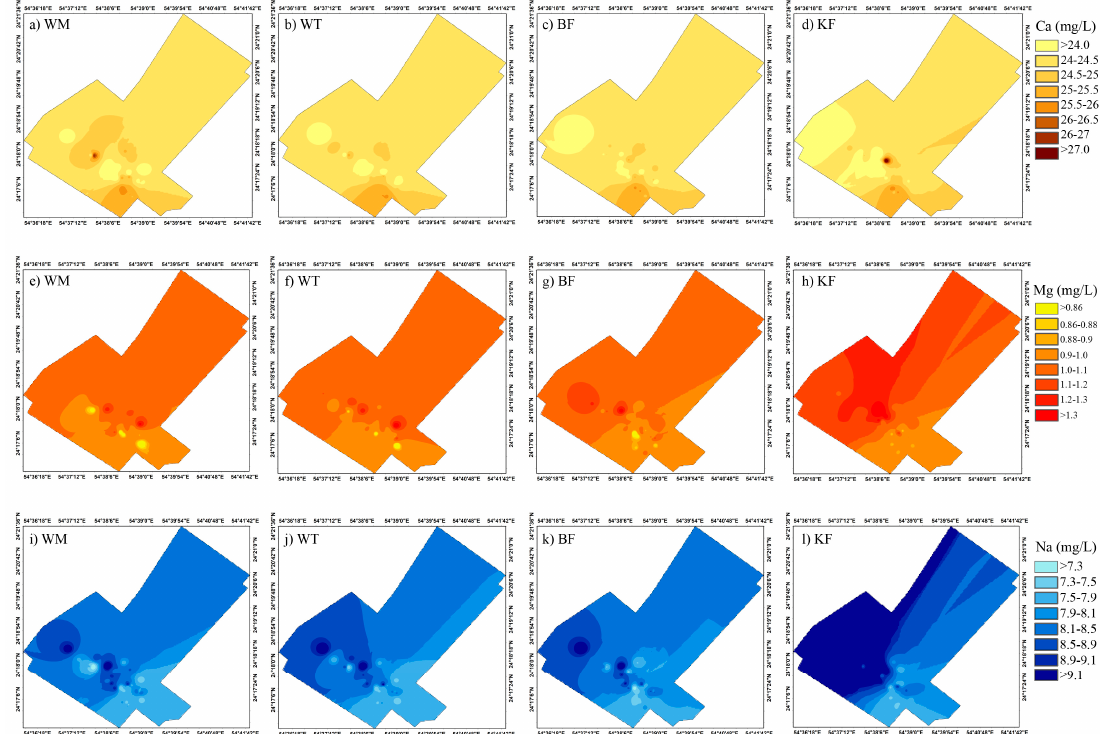
Figure A2. Spatial variation of Cations; ( a – d ) Calcium concentrations for the four sampling points WM, WT, BF and KF respectively. ( e – h ) Magnesium concentrations for the four sampling points WM, WT, BF and KF respectively. ( i – l ) Sodium concentrations for the four sampling points WM, WT, BF and KF respectively.